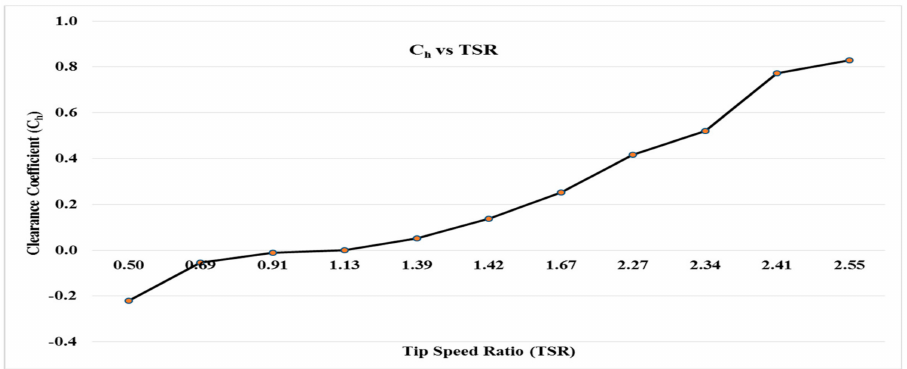
Figure 8. Graph of clearance coe ffi cient vs.